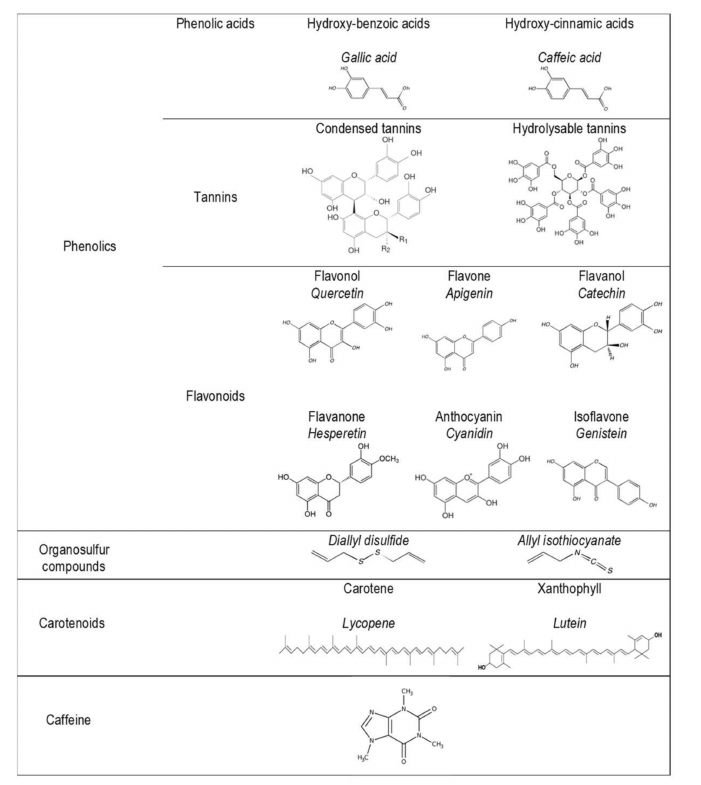
Figure 3. Main phytonutrient family chemical